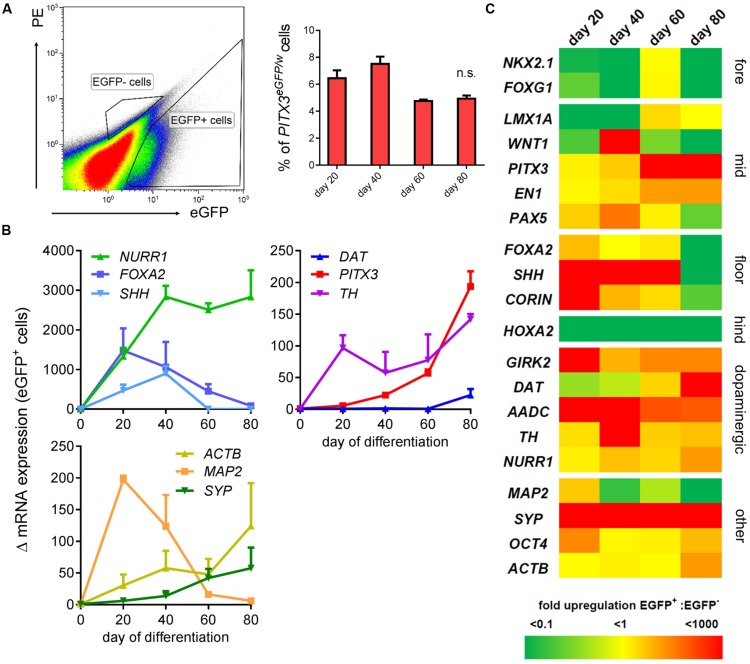
Transcriptional identity of PITX3eGFP/w cells is midbrain dopaminergic. A second flow cytometry experiment was conducted to collect eGFP+ and eGFP- cells for total RNA extraction and qPCR analysis on days 20, 40, 60, and 80. (A) Shows a typical FACS plot at day 20, and the strategy used to isolate eGFP+ and eGFP- cells. This graph shows the percentage of live cells (from three independent experiments; ± SEM) sorted into the eGFP+ gate at each time point. (B) qPCR analysis of the mRNA from at least 106 eGFP+ cells showed upregulation of neuronal and midbrain dopaminergic genes (compared to hPSCs; one-way ANOVA with post hoc Dunnett’s test, p < 0.001-0.05, n = 3 technical replicates of samples aggregated from three independently differentiating wells) at points between days 20 and 80 of differentiation. The y-axis shows the fold change in mRNA levels (Δ mRNA). (C) Shows a heat map of the ratio of mean transcript levels in the positive fraction : negative fraction. Fore, forebrain; mid, midbrain; floor, floorplate; hind, hindbrain.